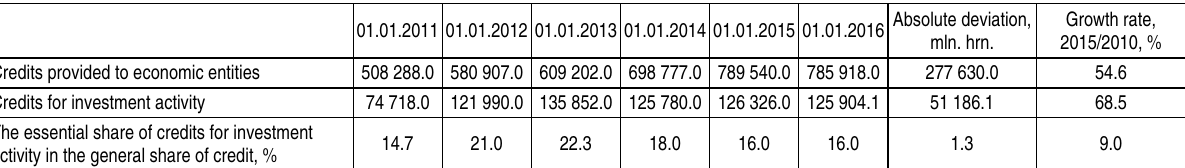
Table 3. The dynamics of credits provided by the banks into real sector of economy of Ukraine for 2010-2015, mln.